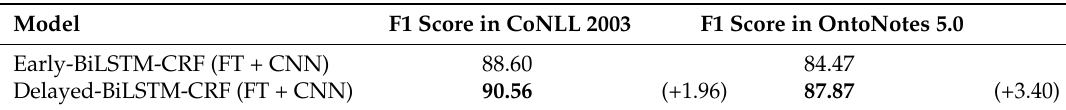
Table 4. Comparison between the delayed and early combination